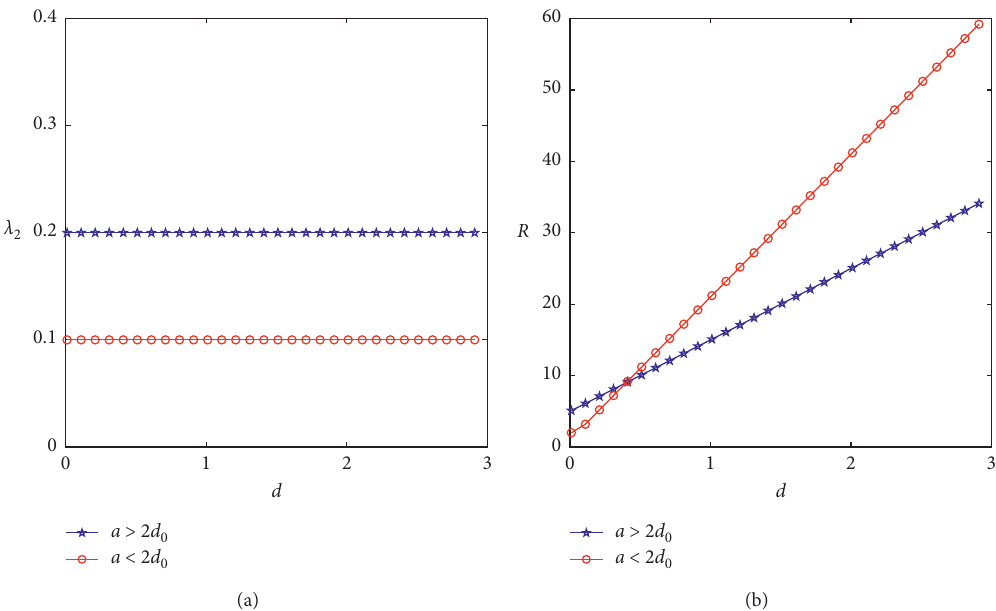
Figure 7: When N is even, the synchronizability of Network I changes with the interlayer coupling strength d of the leaf nodes. (a) λ changes with d ( d changes from 0.01 to 3); (b) R changes with d ( d changes from 0.01 to 3).